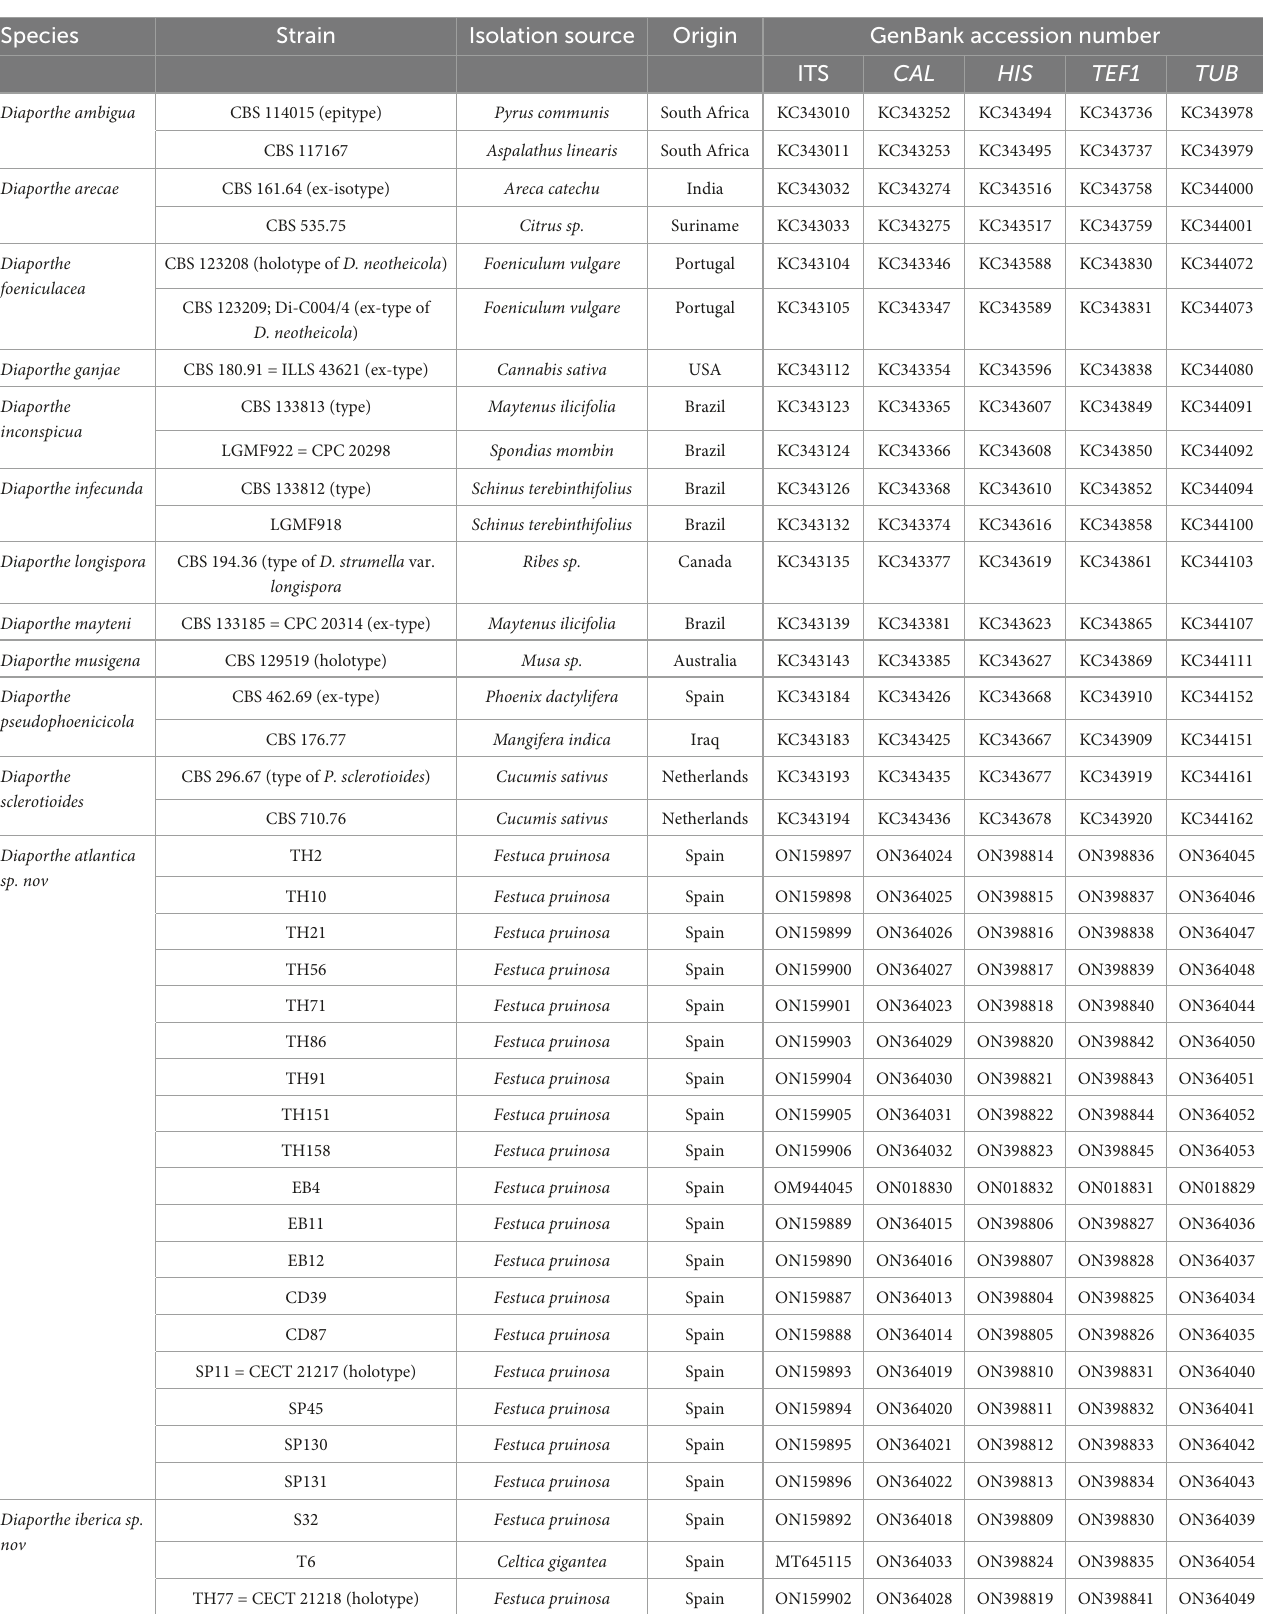
TABLE 1 Diaporthe species, host plant, geographic origin, and GenBank accession numbers of strains used in the study. ( Festuca rubra subsp. pruinosa = Festuca pruinosa